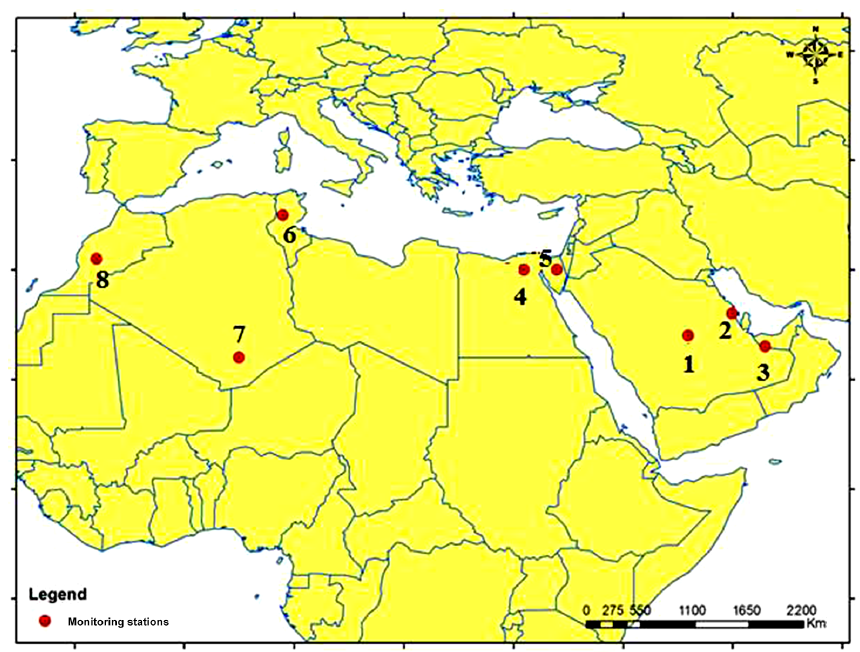
Figure 1. Location map of the AERONET stations used in this study with numbers on the map representing stations’ locations: 1 – Solar Village; 2 – Bahrain; 3 – Mezaira; 4 – Cairo; 5 – Sedé Boqer; 6 – Ben Salem, 7 – Tamanrasset; and 8 –